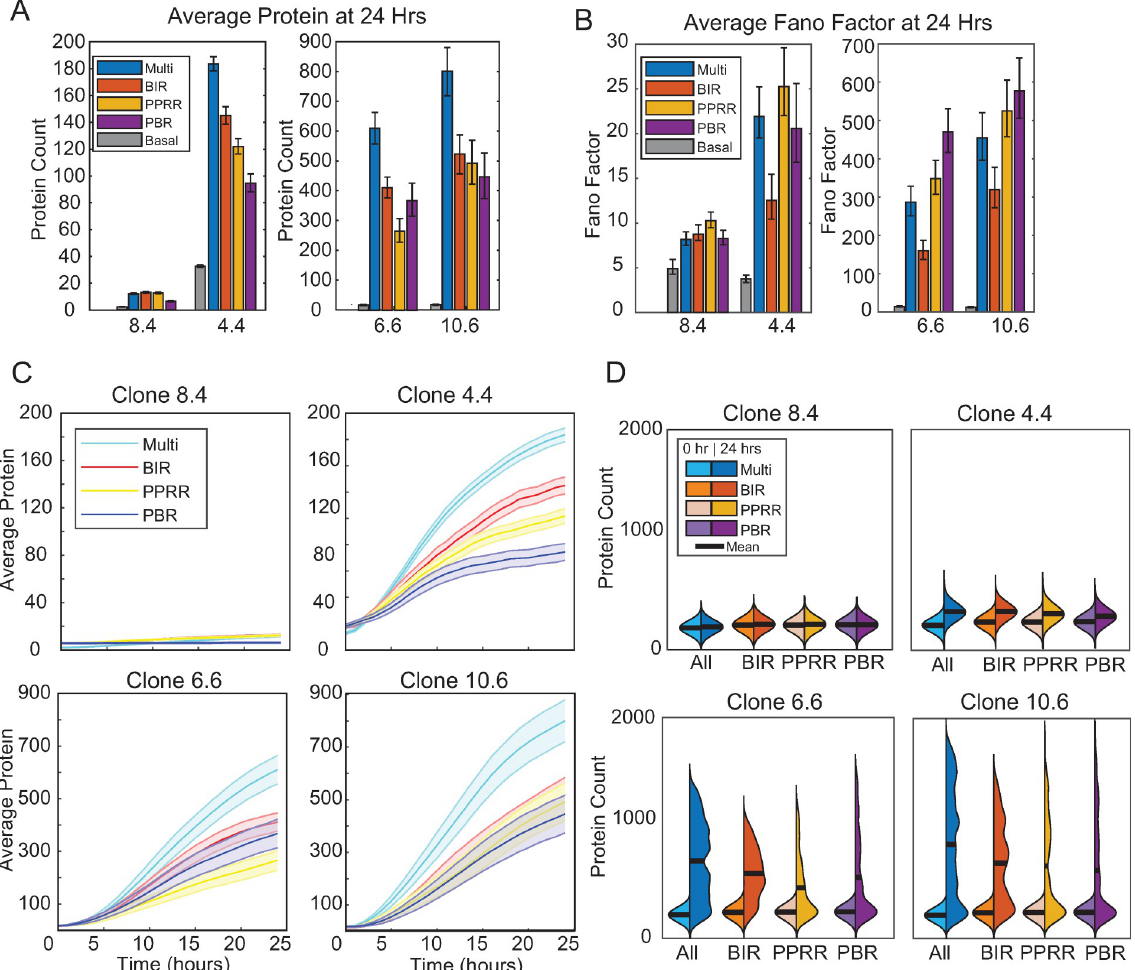
Fig 7. Multi-step activation can be broken down into discrete activation lines which influence noise and protein counts by 24 hours. (A-B) Average protein counts (A) and Fano factor (B) for the four activation options at 24 hours. Protein counts were generated through stochastic simulation for 1,000 cells for each parameter combination. Error bars represent 95% bootstrapped confidence intervals. (C) Simulated trajectory protein data of 50 representative cells out to 24 hours of the four activation lines with the four integrations. (D) Violin kernel fitting of protein distributions at basal conditions and at 24 hours of the four activation lines with the four integrations. Black bar represents the mean.